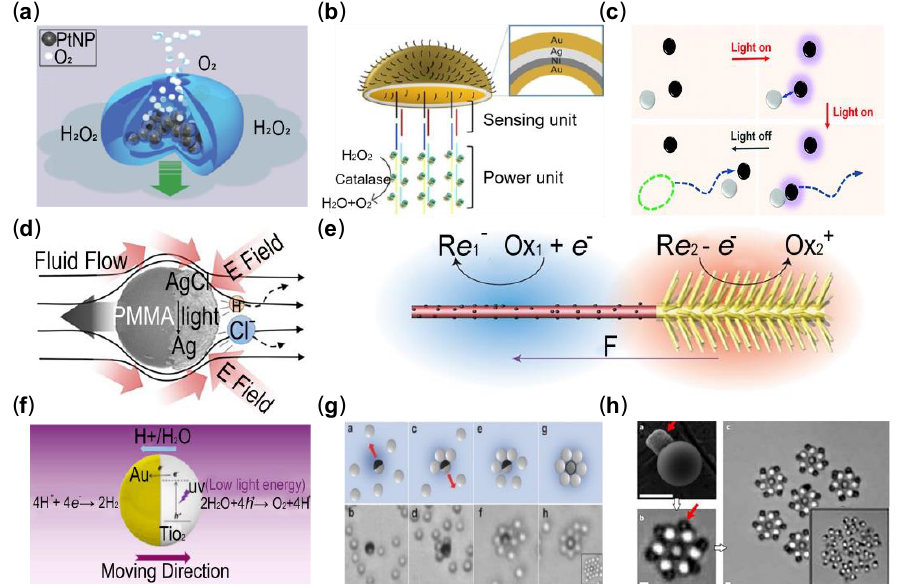
Figure 6. Schematic illustration of chemical with light-induced propulsion and swarming methods. ( a ) A profile of the platinum-loaded stomatocyte [149] (Reproduced with permission from Wilson et al., Nature Chemistry; published by Nature Portfolio, 2012); ( b ) The basic structure of jellyfish- like nanomotor produced by Zhang et al. [53] (Reproduced with permission from Zhang et al., ACS Applied Material and Interfaces; published by American Chemical Society, 2019); ( c ) Process of the chemically active and passive colloids under UV light [152] (Reproduced with permission from Yu et al., Chemical Communications; published by Royal Society of Chemistry, 2018); ( d ) A model sys- tem of propulsion of PMMA particle to better understand self-diffusiophoresis mechanism [54] (Re- produced with permission from Zhou et al., Langmuir; published by American Chemical Society, 2018); ( e ) Illustration of the structure of the Janus nanotree-particle [153] (Reproduced with permis- sion from Dai et al., Nature Nanotechnology; published by Nature Portfolio, 2016); ( f ) TiO 2 – Au Ja- nus micromotor propelled under UV light by catalyzing water [59] (Reproduced with permission from Dong et al., ACS Nano; published by American Chemical Society, 2016); ( g ) Growth of the first shell of the non-equilibrium assembly of the swarming particle [154] (Reproduced with permission from Singh et al., Advanced Materials; published by Wiley, 2017) ( h ) The rapid assembly process of self-spinning swarming particles is triggered by a focused laser beam [155] (Reproduced with per- mission from Aubret et al., Nature Physics; published by Nature Portfolio, 2018). Self-diffusiophoresis is a mechanism that produces chemical species from the hemi- sphere of the Janus particle continuously to generate a steady chemical gradient, which leads to the movement of the motor towards the inert side [30]. For example, in hydrogen peroxide solutions, t he generated chemical gradient is able to drive the particles due the following reaction: